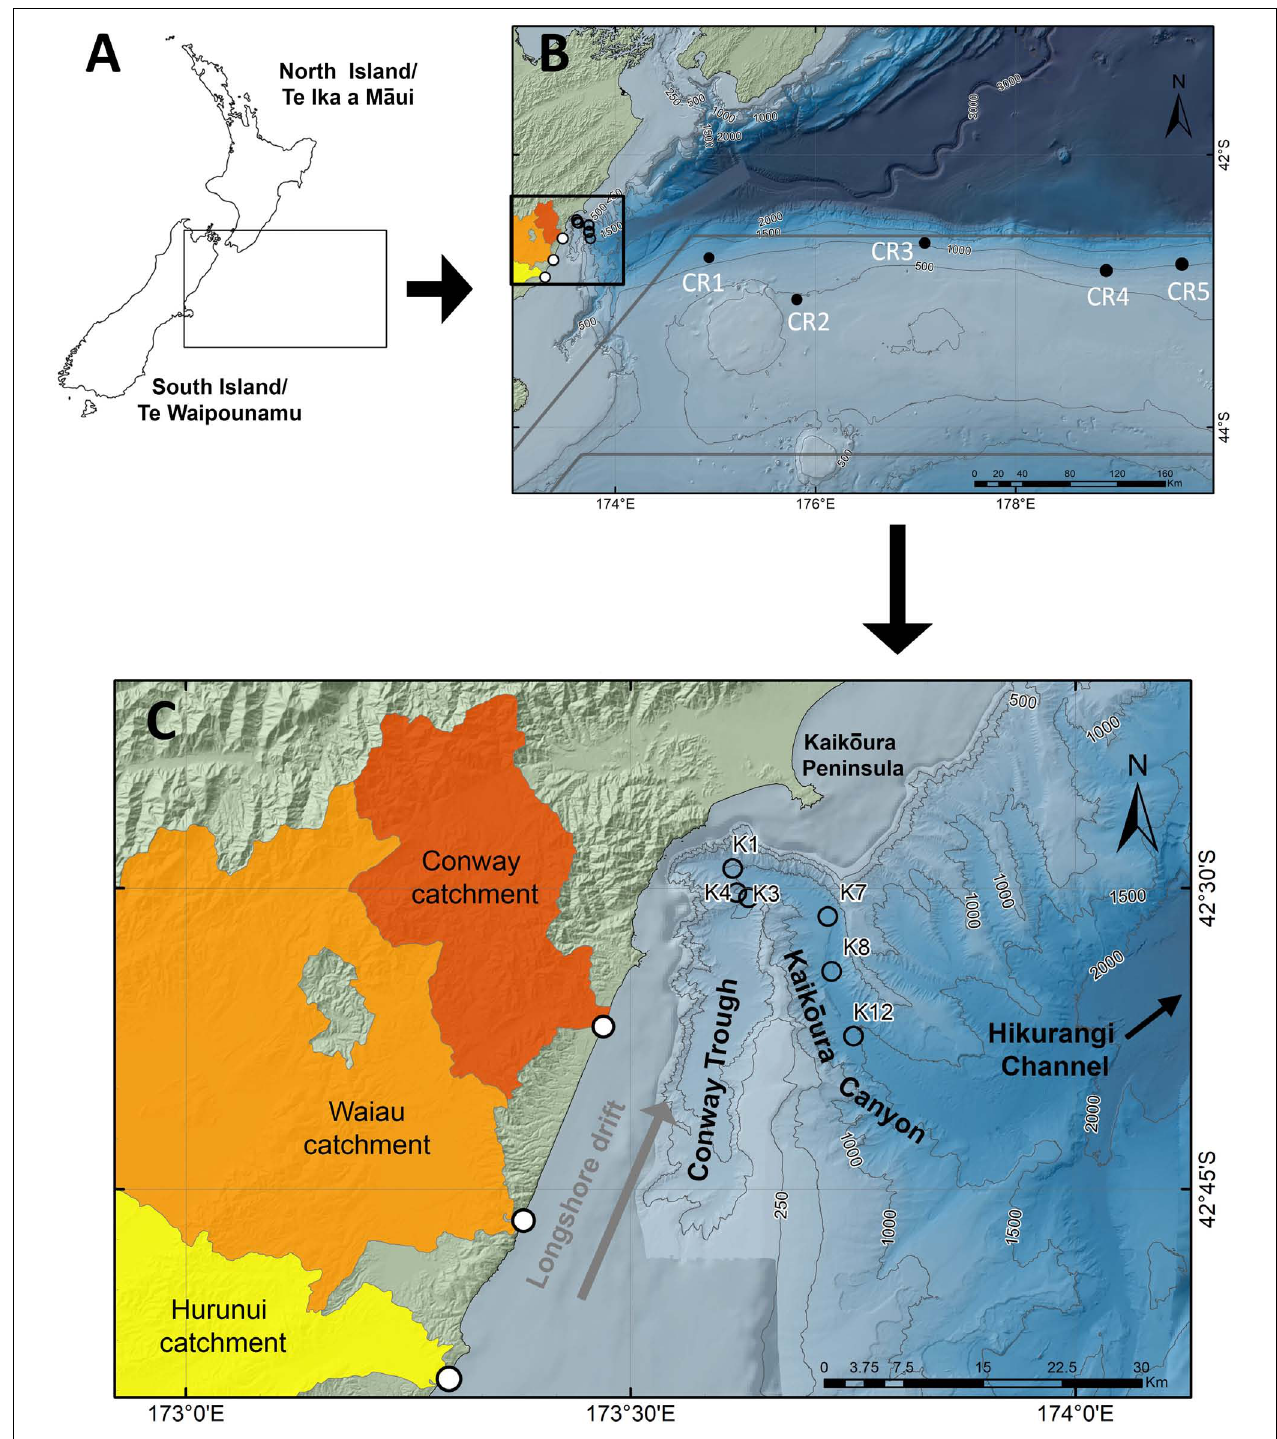
FIGURE 1 | Site and sample location maps of the east coast Kaik¯oura Canyon, showing: (A) the position relative to New Zealand, (B) the position of the Kaik¯oura Canyon sampling sites (open circles) relative to the marine sediment source sites (solid circles) on the Chatham Rise (CR) and (C) the positions of the main inflow rivers relative to the Kaik¯oura Canyon and Conway Trough, and the predominant longshore drift direction. Approximate position of the Subtropical Front (STF) boundaries is shown by gray lines in panel (B) .